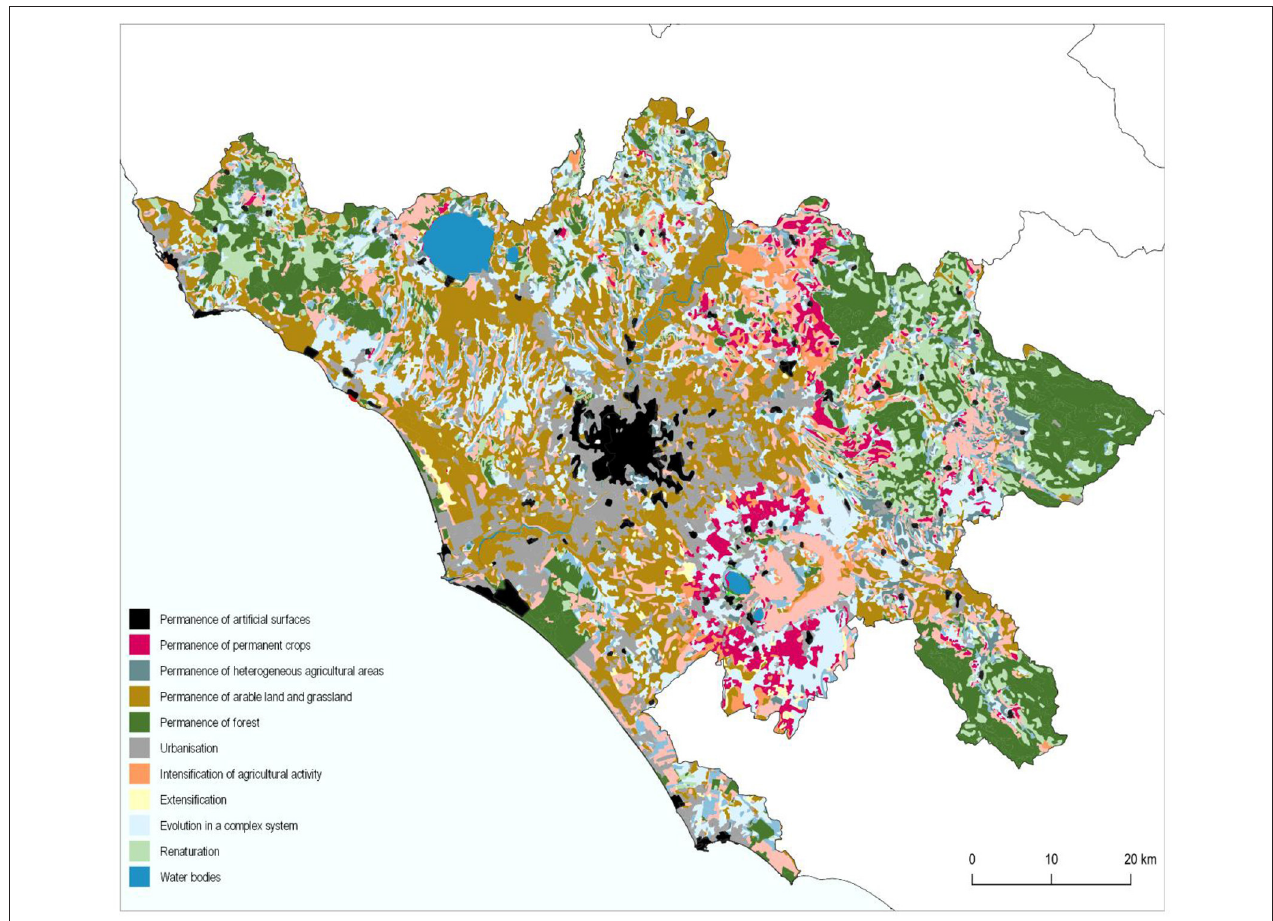
FIGURE 1 | Land use transitions in the metropolitan city of Rome (source: authors elaboration from CNR-TCI 1960 and Corine Land Cover 2018).